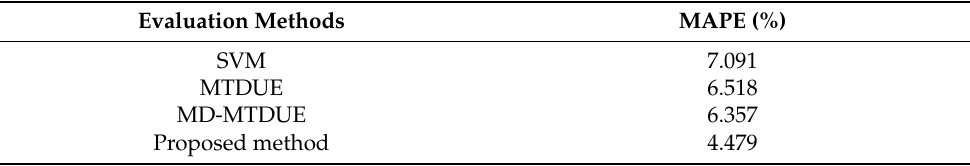
Table 4. MAPE values of the model under different virtual sample generation methods.